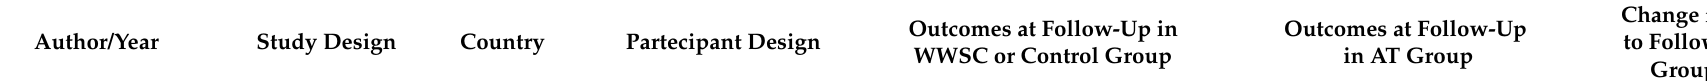
Table 4. Follow-up outcomes in WWSC group, control group or AT group and change from baseline to follow-up between